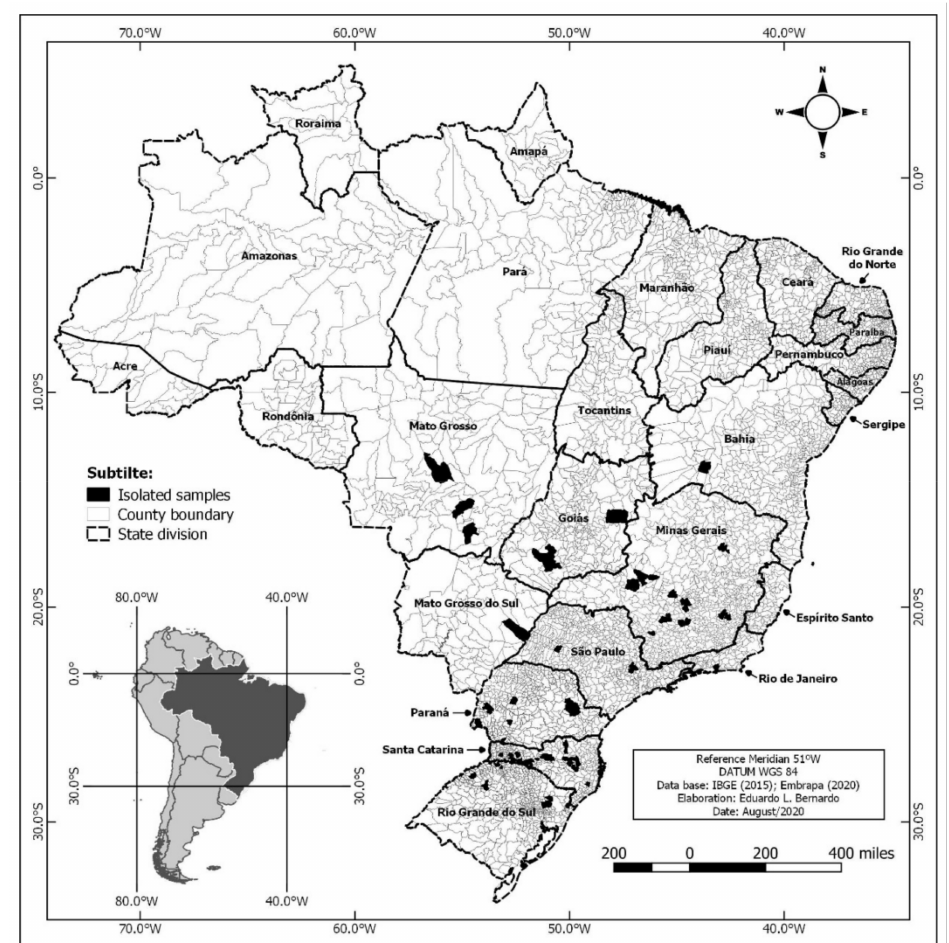
Figure 1. Geographic distribution of 130 Salmonella strains from pig salmonellosis outbreaks in 10 Brazilian states from 2011 to